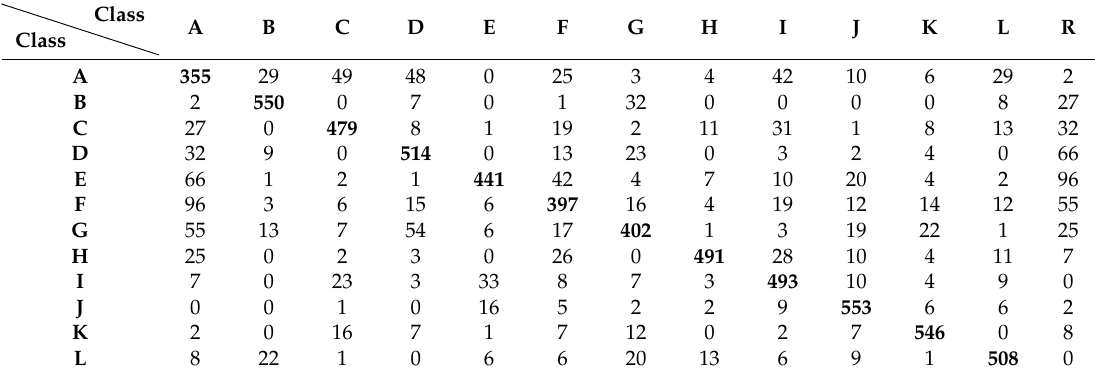
Table 3. Classification results for Elliptical feature set with MLP